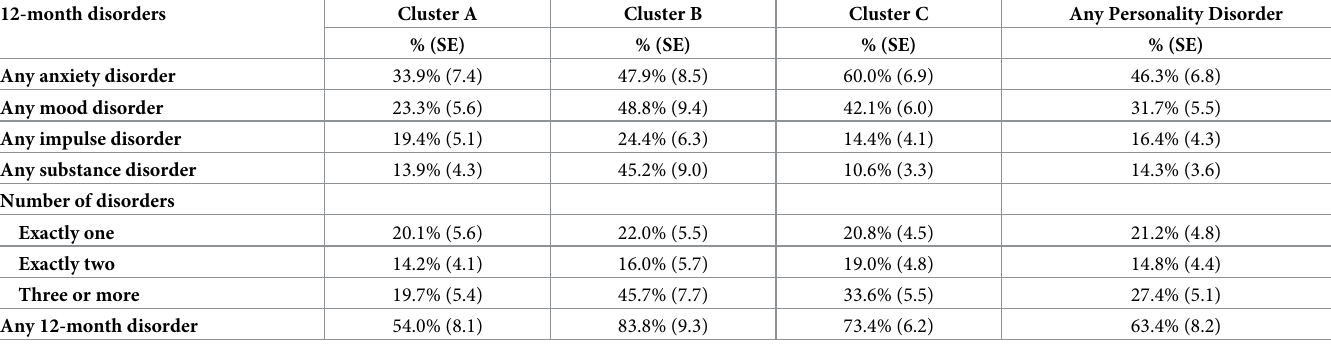
Table 4. Prevalence of other 12-month mental disorders among those with personality disorders in the São Paulo Metropolitan Area.